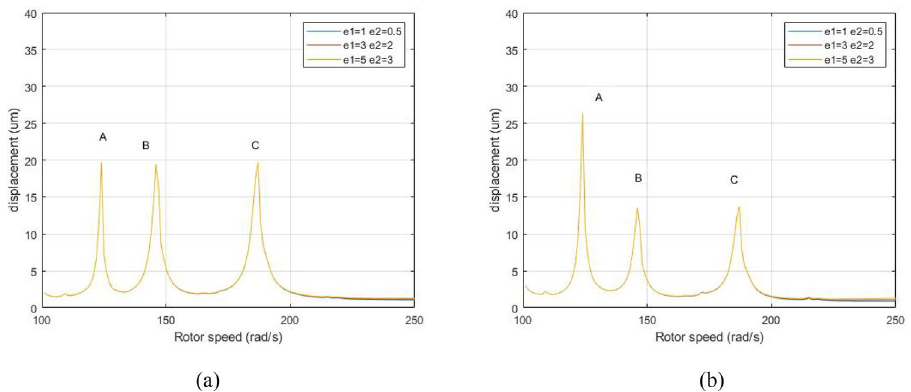
Figure 17. Amplitude-frequency response curve (λ = 1. 75, F 0 = 100, A max = 200) ( a ) LP rotor ( b ) HP rotor.